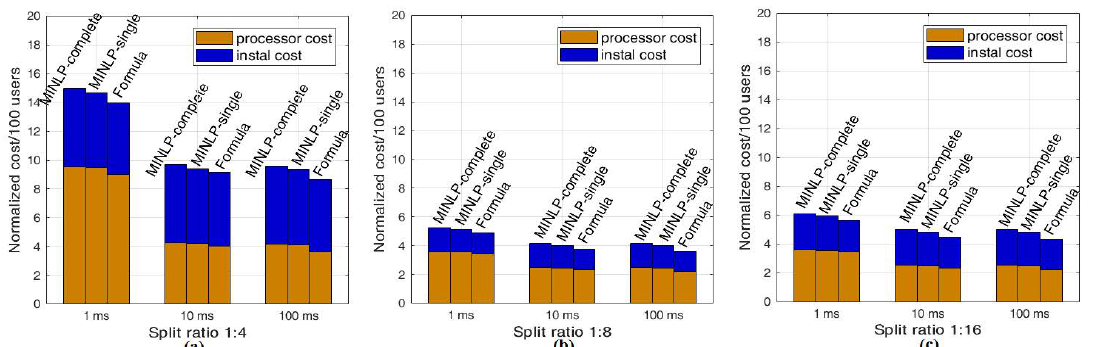
Figure 4. Comparison of normalized cloudlet deployment cost/100 users with population density 4000 persons/km 2 computed using the modified analytical formula designed in this paper with the complete MINLP framework proposed in [8] and MINLP on a single TDM-PON FiWi branch against D QoS values of 1 ms, 10 ms, and 100 ms with ( a ) split-ratio 1:4; ( b ) split-ratio 1:8; and ( c ) split-ratio 1:16.